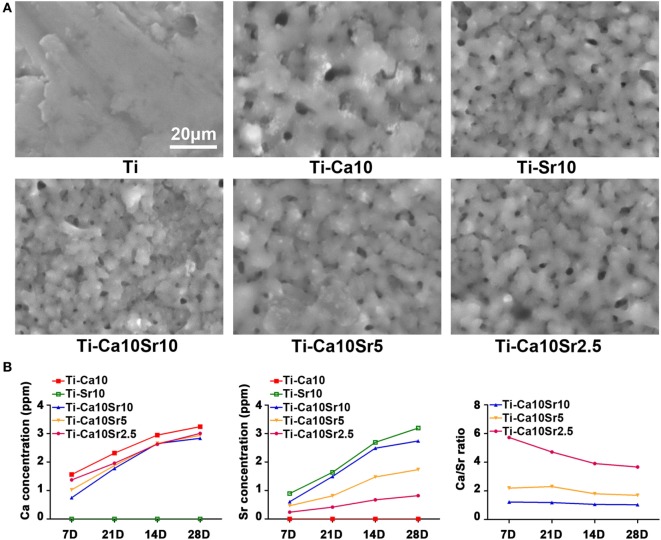
(A) The surface morphology of different samples displayed by scanning electron microscopy. Scale bar, 20 µm. (B) Calcium (Ca) and strontium (Sr) releasing concentrations and ratios released from different samples at day 7, 14, 21, and 28.